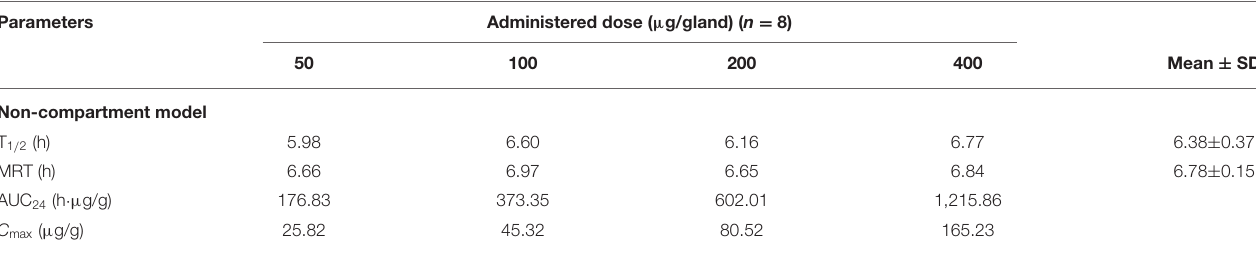
TABLE 3 | The main pharmacokinetic parameters of rifaximin in mammary gland following an intramammary administration with single dose of 50, 100, 200, and 400 µ g/gland in mice and analyzed by non-compartment model. Parameters